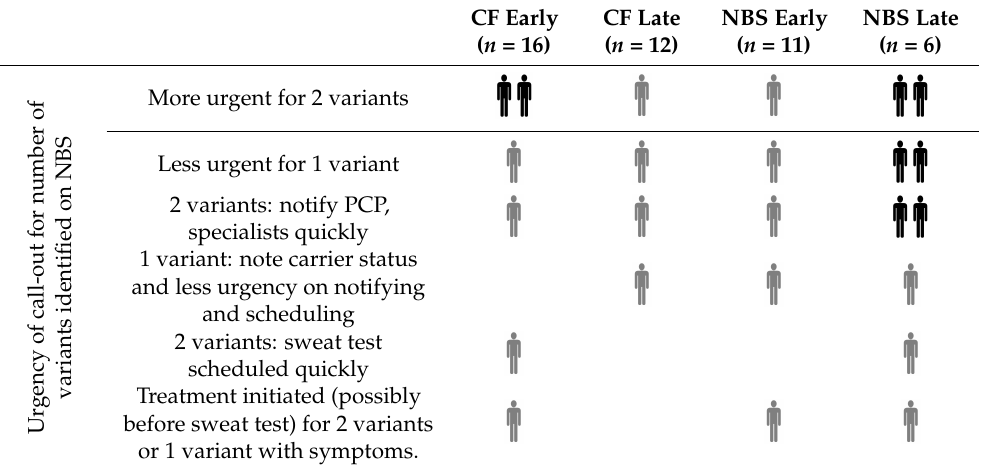
Table 6. Key Themes identified listed by analysis groups regarding the urgency of results called -out to PCPs from the newborn screening program; themes identified by at least 30% of the group are represented by one figure; themes identified by at least 60% of the group are represented by two